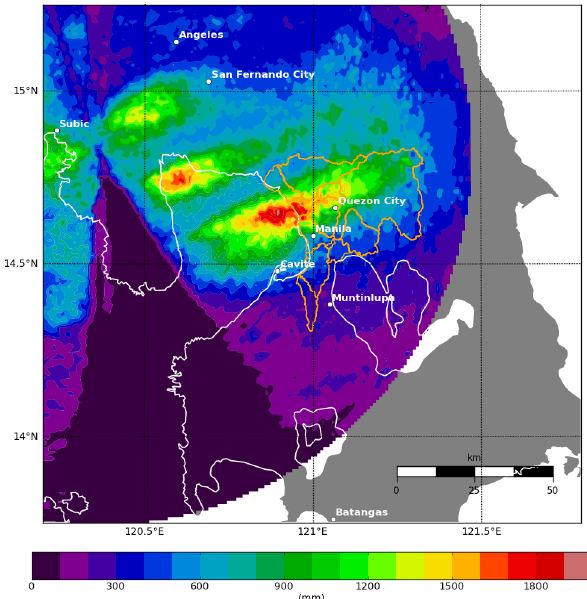
Fig. 3. Rainfall accumulation for Metropolitan Manila region, Philippines, from 6–9 August 2012, based on the S-band radar lo- cated near Subic city, using wradlib modules io (reading NetCDF data), georef (geo-referencing), clutter (clutter identification), ipol (gap filling), adjust (for mean field bias adjustment), and vis (for plotting over a map). The orange lines indicate watersheds draining to Manila Metropolitan region. Note that the southern sectors of the radar exhibit significant beam shielding caused by Mount Natib, a volcano and caldera complex located in the province of Bataan. Please note that a corresponding code recipe for this figure has not been added to the wradlib documentation page because the code is part of a more complex application built on wradlib.